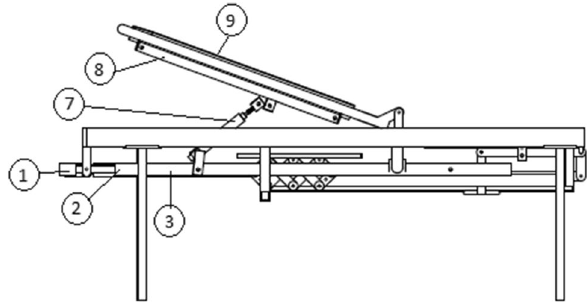
Fig. 5 Bed—raised backrest position. (1: Screw, 2: Nut, 3: Sliding member, 7: Link, 8: Shaft, 9: